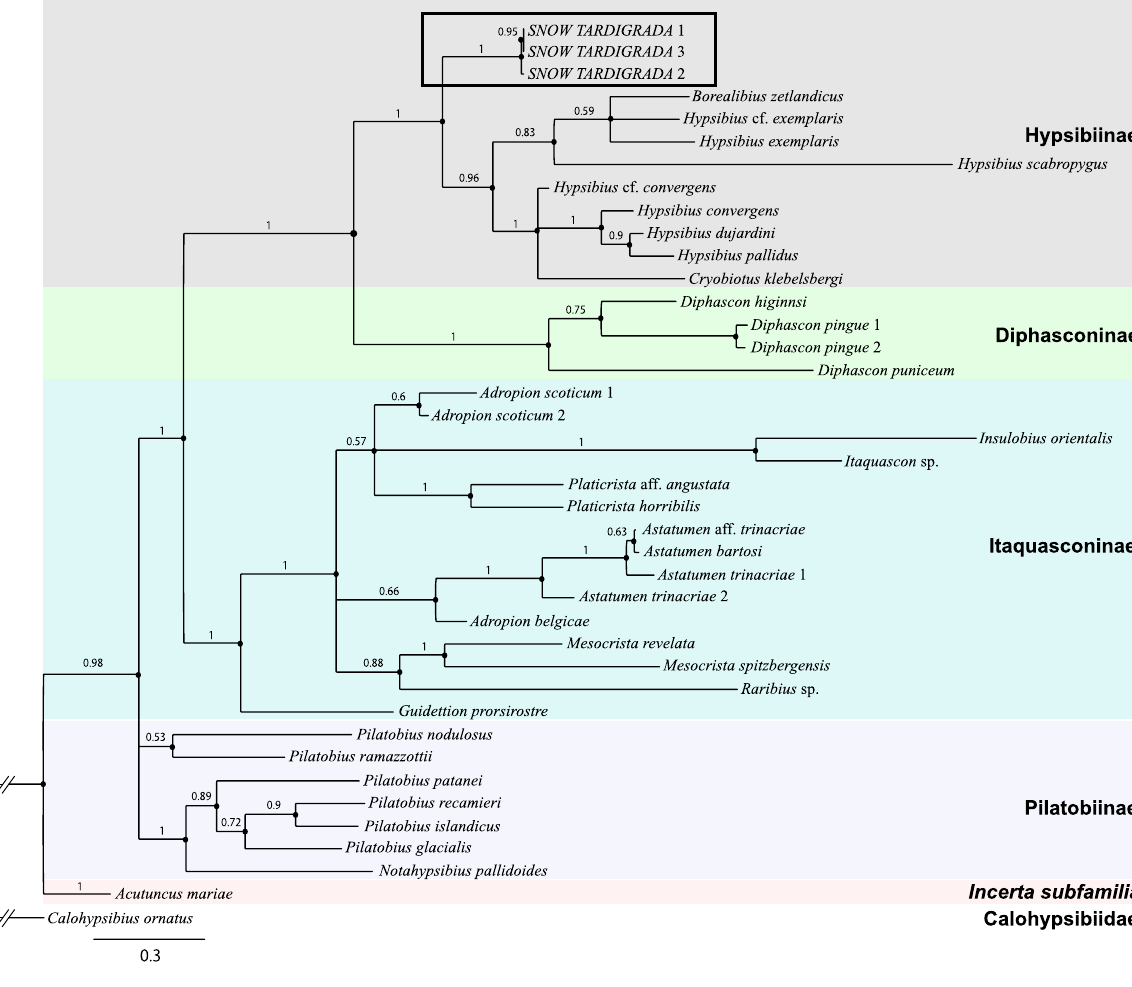
Figure 2. The phylogenetic position of Hypsibius sp. from Mt. Gassan (clade in the frame) in the Bayesian tree constructed from concatenated nucleotide sequences of the three molecular markers, one mitochondrial (COI) and two nuclear (18S rRNA, 28S rRNA). Support values are presented at the